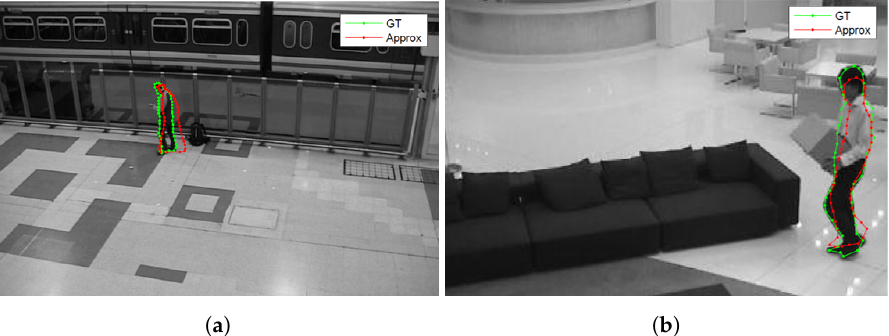
Figure 10. Detection of a pedestrian in selected scenes of the CDnet2014 collection. ( a ) PETS2006 scene, frame 1128. ( b ) Sofa scene, frame